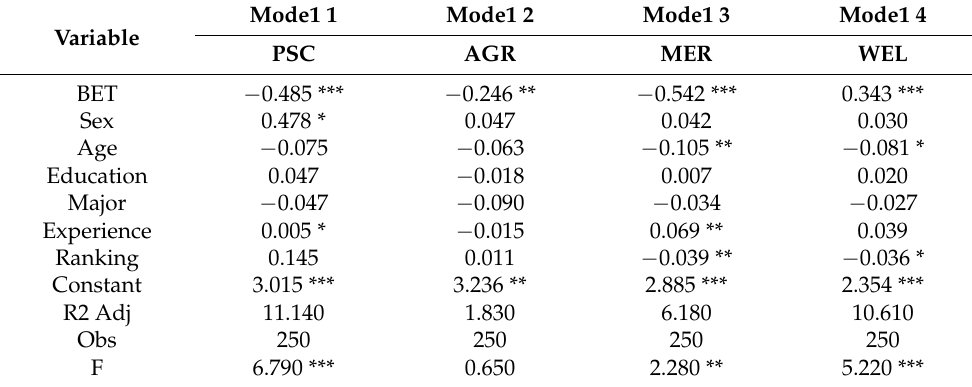
Table 11. Regression results of Iraqi